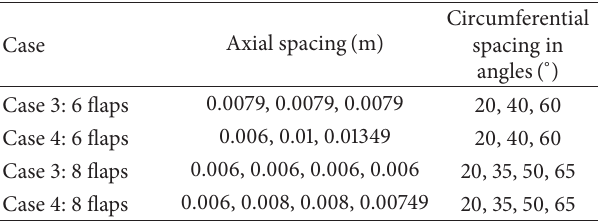
Table 3: New geometric parameters used for 2-microflap configu- rations (case 4 ).